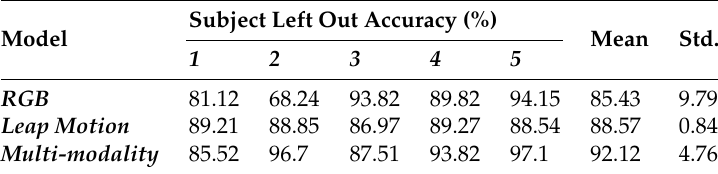
Table 7. Results for the models when trained via leave-one-subject-out validation. Each subject column shows the classification accuracy of that subject when the model is trained on the other four.